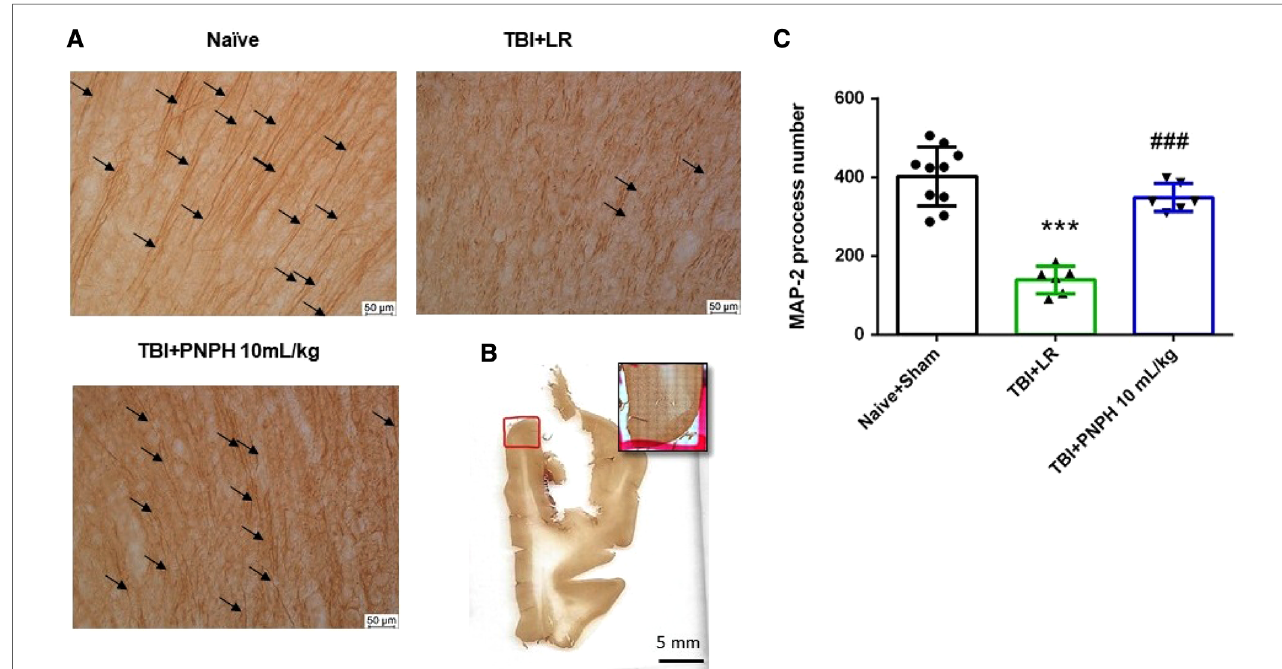
FIGURE 10 Effect of PNPH on MAP-2 – identi fi ed gray matter neuronal dendrites after TBI without hemorrhagic shock. ( A ) Representative images of MAP-2 immunostaining from naïve pig and pigs infused with 10 ml/kg LR or 10 ml/kg PNPH 2 h after TBI. Arrows point to dendritic segments with >50 µm length from gyrus of the cortex adjacent to the gyrus where CCI was produced. ( B ) Example of area of gyrus analyzed is outlined in red. ( C ) The number of long neocortical dendrites per coronal section averaged over 10 – 12 sections are plotted for the combined Naïve+Sham group ( n =10) and for TBI groups infused with 10 ml/kg LR ( n =6) and 10 ml/kg PNPH ( n =6). The number of long dendrites was decreased in the TBI group infused with LR compared to the Naïve+Sham group and to the TBI group infused with PNPH. Mean±SD and individual data for each pig are shown. *** P <0.001 vs. combined Naïve +Sham groups, ### P <0.001 vs. LR group determined by one-way ANOVA and the Holm-Sidak procedure for multiple